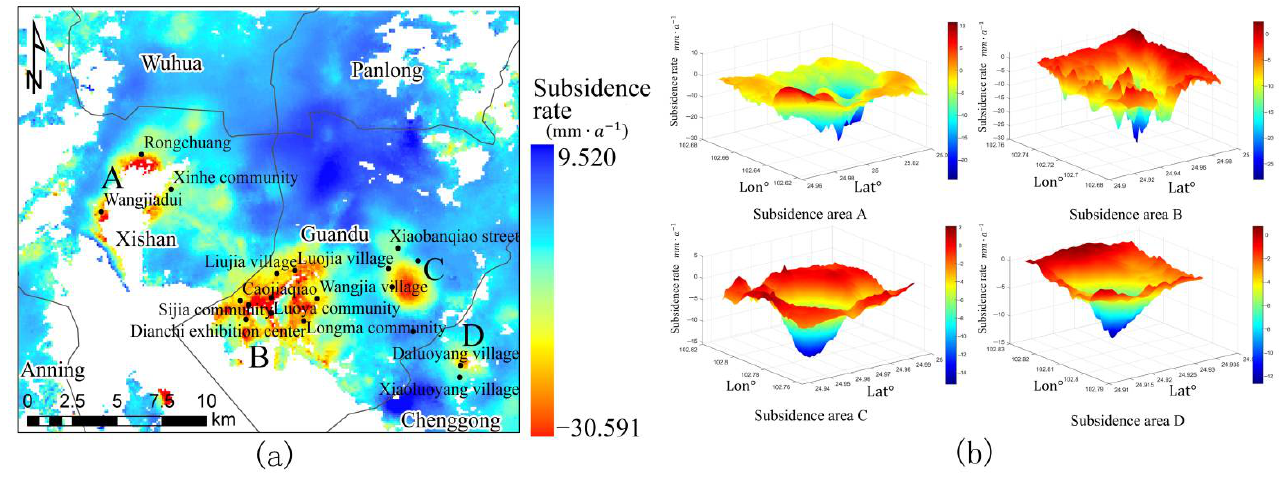
Figure 8. ( a ) Deformation rate of the main urban area of Kunming from 2018 to 2021. ( b ) Three- ( a ) Deformation rate of the main urban area of Kunming from 2018 to 2021. dimensional surface-subsidence-rate map of each subsidence area. ( b ) Three-dimensional surface-subsidence-rate map of each subsidence